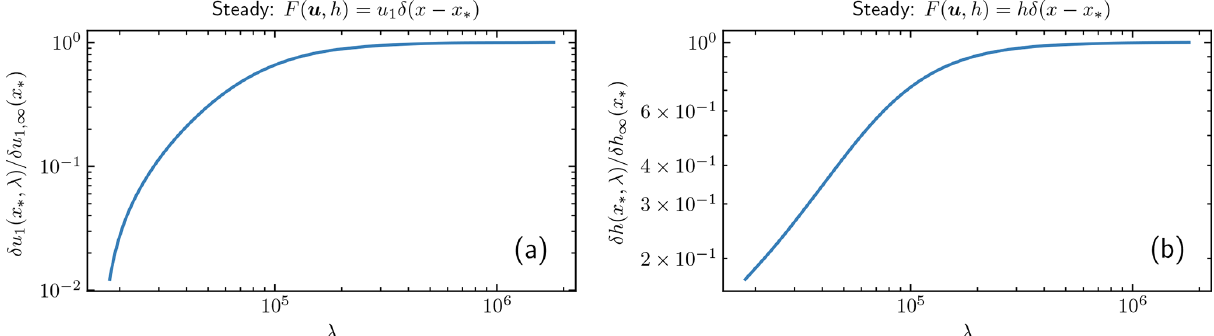
Figure 3. The response at (cid:48) s with different wavelengths λ in the perturbation of C in Eq. (28). (a) δu 1 (x ∗ ,λ)/δu 1 , ∞ (x ∗ ) ; (b) δh(x ∗ ,λ)/δh ∞ (x ∗ ) .